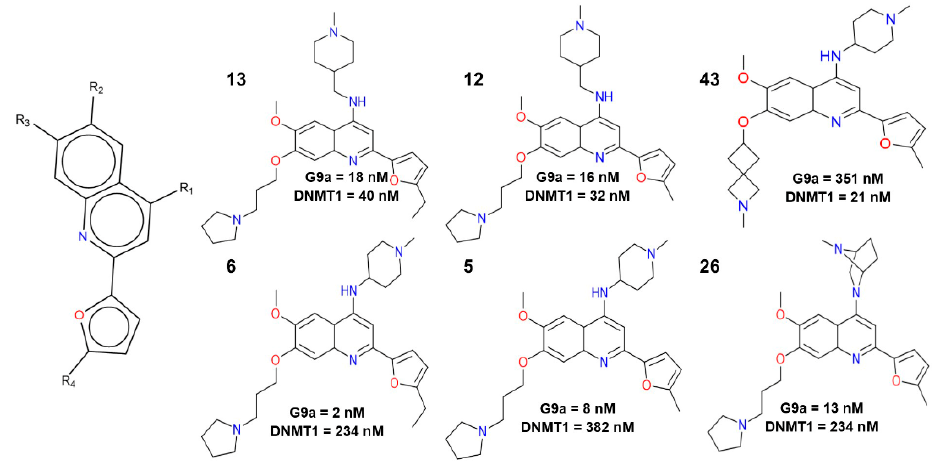
Figure 1. Selected 4-aminoquinoline compounds with the highest activity reported for G9a and DNMT1.